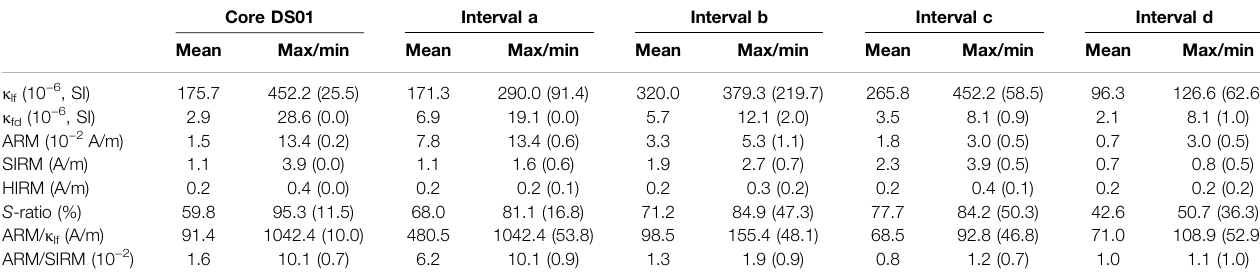
TABLE 1 | Ranges of variation of the magnetic parameters for core DS01 and intervals (a – d). Core DS01 Interval a Interval b Interval c Interval d Mean